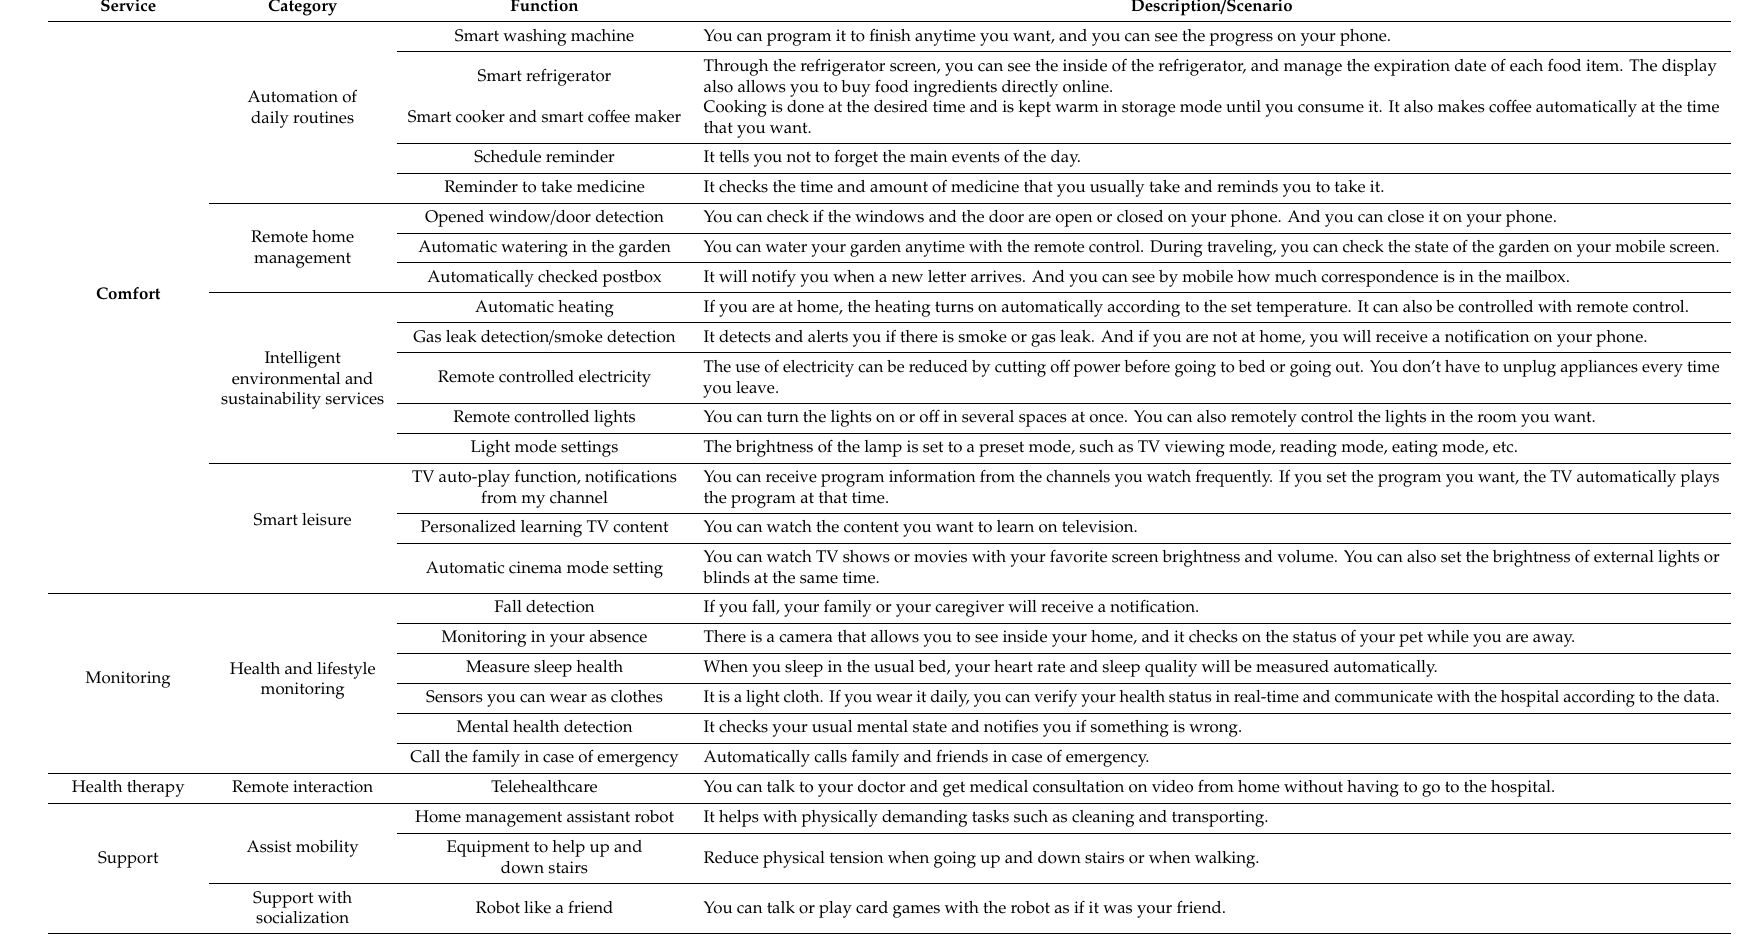
Table A2. Smart home